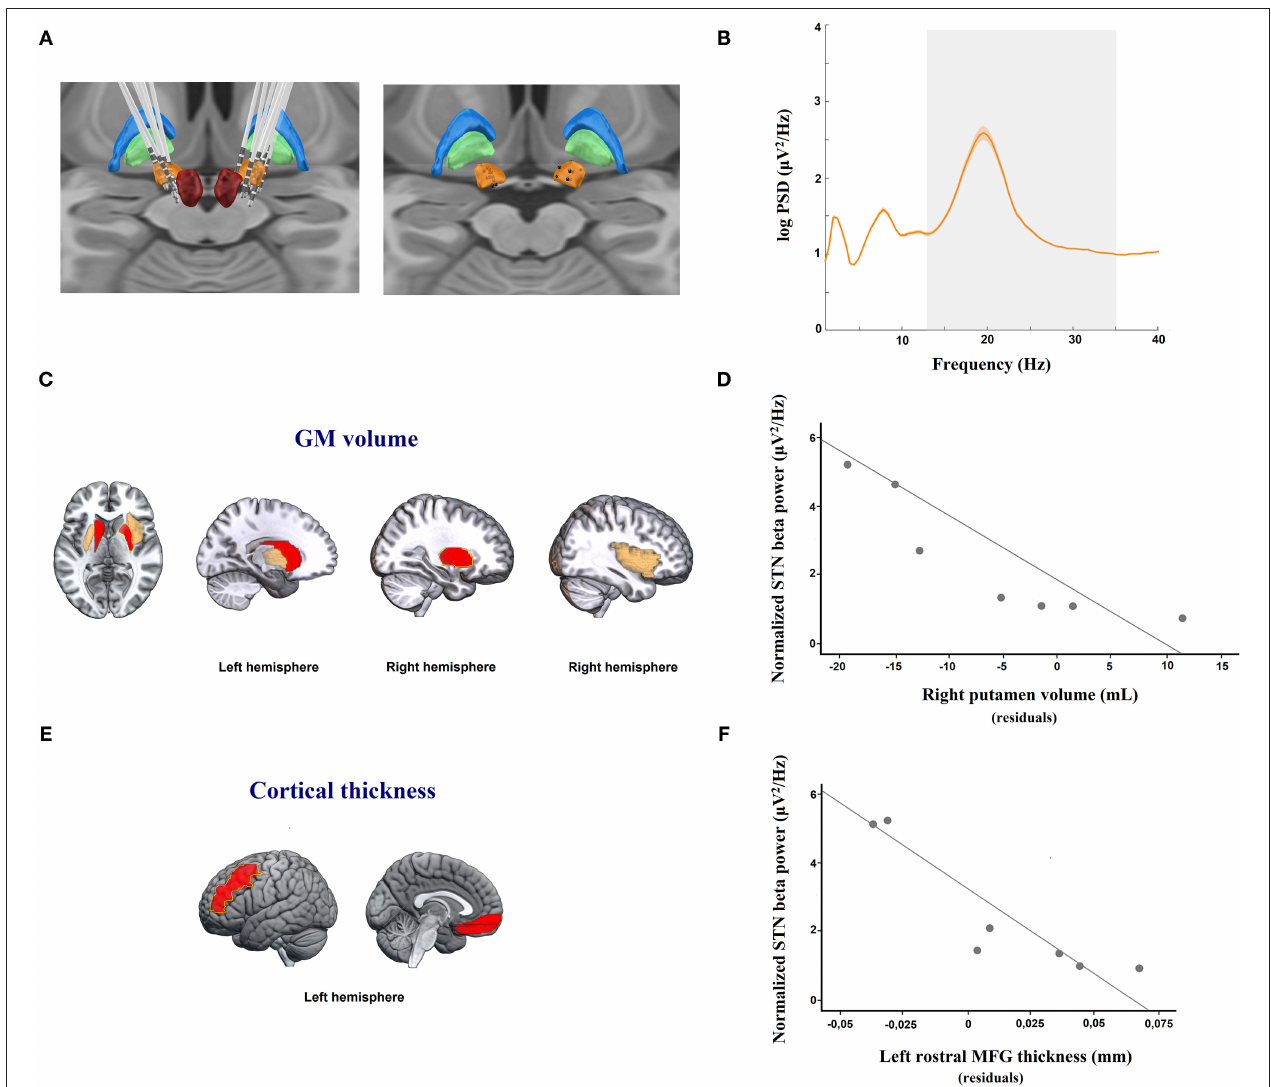
FIGURE 1 | (A) DBS electrode location. Images were reconstructed and 3-D visualized using the Lead-DBS toolbox to determine the coordinates of each electrode contact. Right : DBS electrode localizations of 7 PD patients; and left : simulated location of the position of each bipolar register (black spheres, calculated by averaging the location of each pair of adjacent contacts) in the STN used for LFP analysis. Figures are visualized in the context of a 3D representation of the Morel stereotactic atlas in MNI space (Posterior view). The bilateral subthalamic nucleus (STN; orange), external globus pallidus (GPe; blue), internal globus pallidus (GPi; green), and red nucleus (RN; red) are shown. (B) Resting state STN spectral power in PD patients. Averaged (orange solid line) log-transformed power spectral density for STN-LFPs in 7 patients with Parkinson’s disease off medication are shown. Orange shaded areas depict S.E.M of the mean for each frequency bin across patients. The x-axis represents frequency (Hz), and the y-axis represents the normalized power spectral density (log PSD, µ V 2 /Hz). The gray shaded area indicates the beta frequency spectrum (13–35Hz). (C) Regional analysis of gray matter (GM) volume showing areas negatively correlated, after adjustment for multiple testing, with local field potential (LFP) power in the beta band in the subthalamic nucleus (STN). The yellow line shows the right putamen, which was the only structure retained in the regression model predicting LFP beta activity in the STN ( p < 0.01). (E) Regional analysis of cortical thickness (CT) volume showing areas negatively correlated, after adjustemt for multiple testing, with LFP power in the beta band in the subthalamic nucleus (STN). The yellow line shows the left rostral middle frontal gyrus (MFG), which was the only structure retained in the regression model predicting LFP beta activity in the STN ( p < 0.01). (C,E) The red color denotes brain areas with significant partial correlations after FDR adjustment between regional GM volumes or CT measures and STN LFP beta activity. The yellow color indicates brain areas with a trend toward statistical significance after FDR adjustment between regional GM volumes and STN LFP beta activity. The red and yellows images are overlaid on a standard MNI T1 template. (D–F) Scatterplot graphs illustrating the partial correlations between STN LFP beta power and (D) right putamen nucleus atrophy and (F) left rostral MFG thinning, controlling for age, educational level, and disease duration. For illustration purposes, the y-axis represents the log-transformed power spectral density (log PSD, µ V 2 /Hz), and the x-axis of each scatterplot graph represents the averaged residuals of age, educational level, and disease duration of (D) regional GM volume in the right putamen and (F) CT in the left rostral MFG.